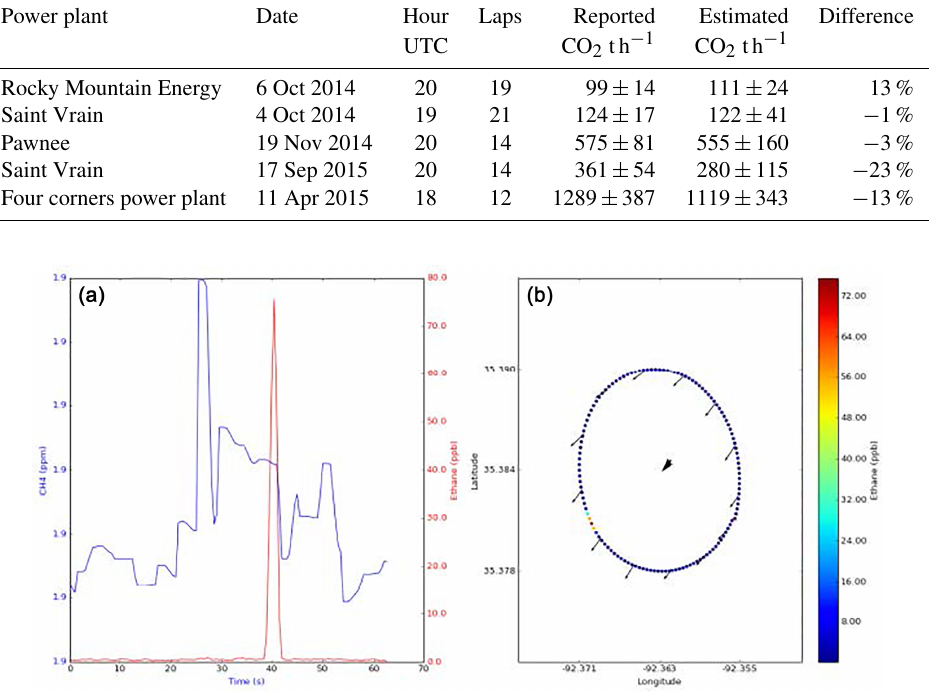
Figure 9. (a) Time series of methane (blue) and ethane (red) along with (b) the geographic distribution of ethane (color bar) and instantaneous winds (arrows) from a single flight loop during the second controlled ethane